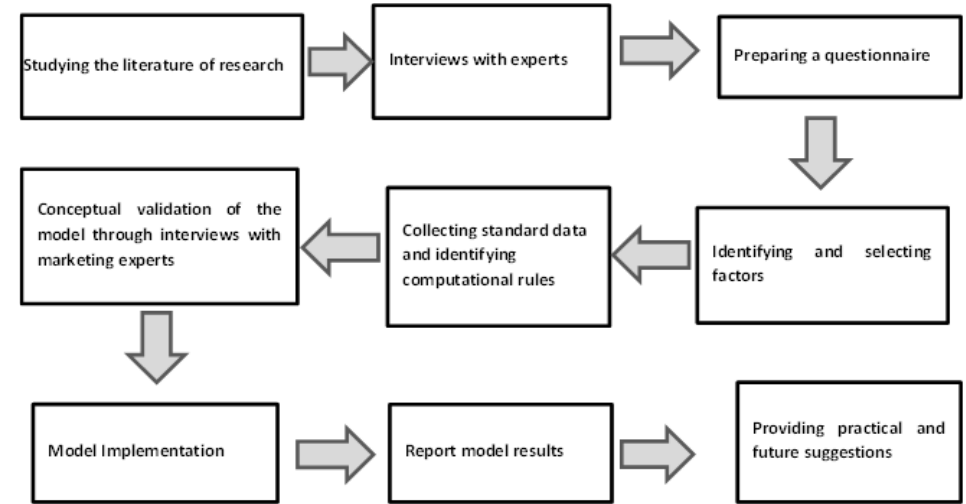
Fig. 4. Executive model of research (source: